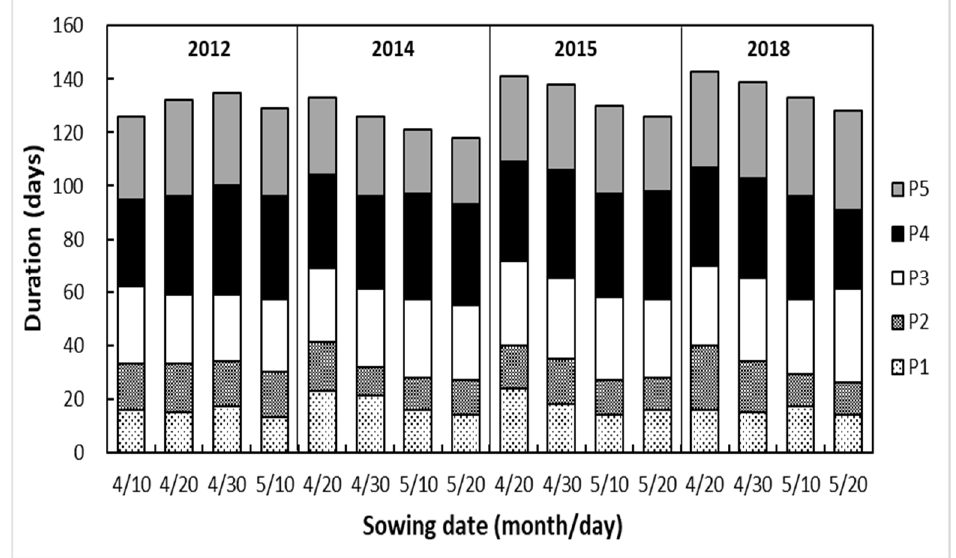
Figure 1. Durations of different growth stages in maize sown on different dates.